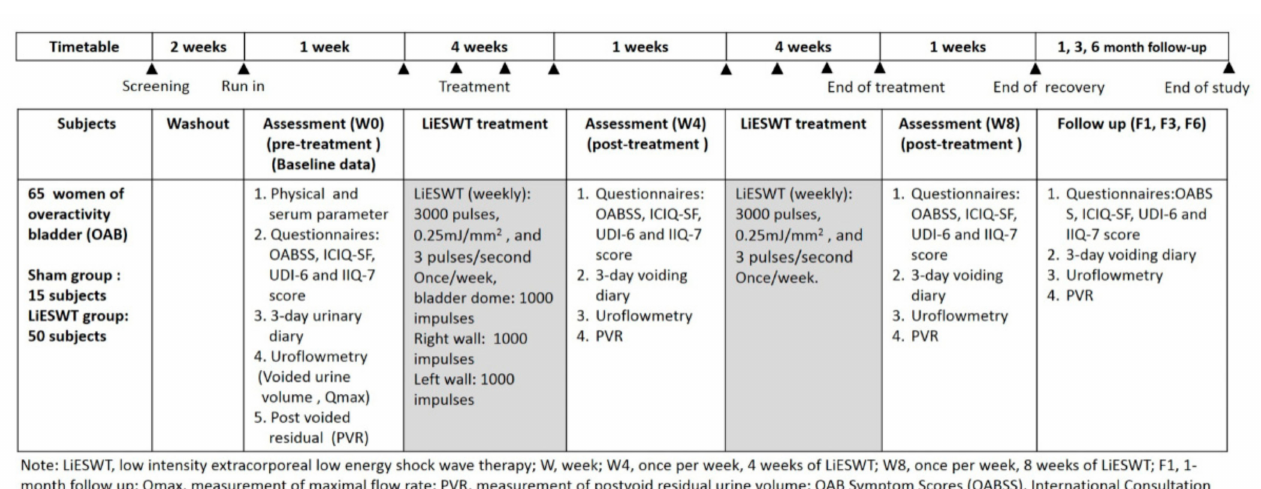
Figure 1. Timetable designed for clinical trial of overactive bladder (OAB) during LiESWT treatment procedure. LiESWT: low intensity extracorporeal shock wave therapy, Qmax: measurement of maximal flow rate, PVR: measurement of post- voided residual (PVR) urine volume, OABSS: overactive bladder symptom scores, ICIQ-SF: international consultation on incontinence questionnaire-short form, UDI-6: urogenital distress inventory-short form, IIQ-7: incontinence impact